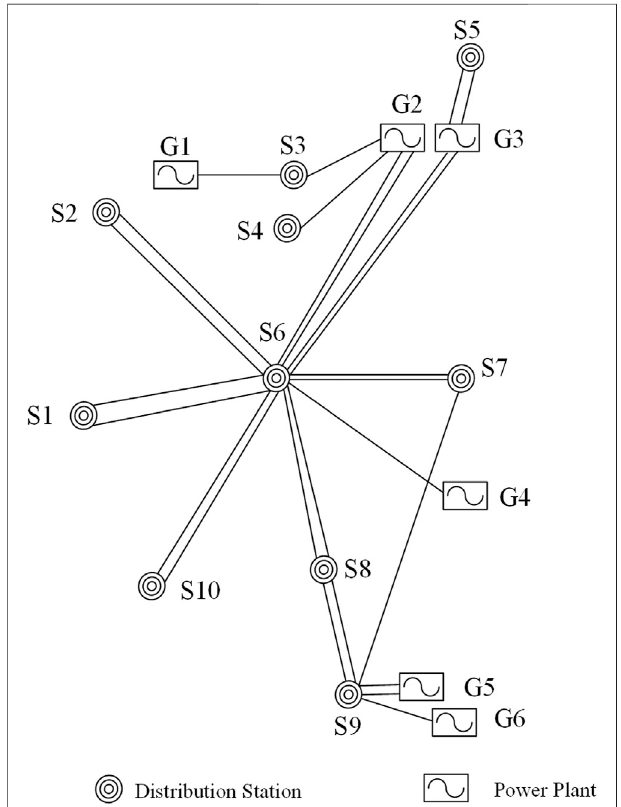
FIGURE 9 | The test system from a region in southwest